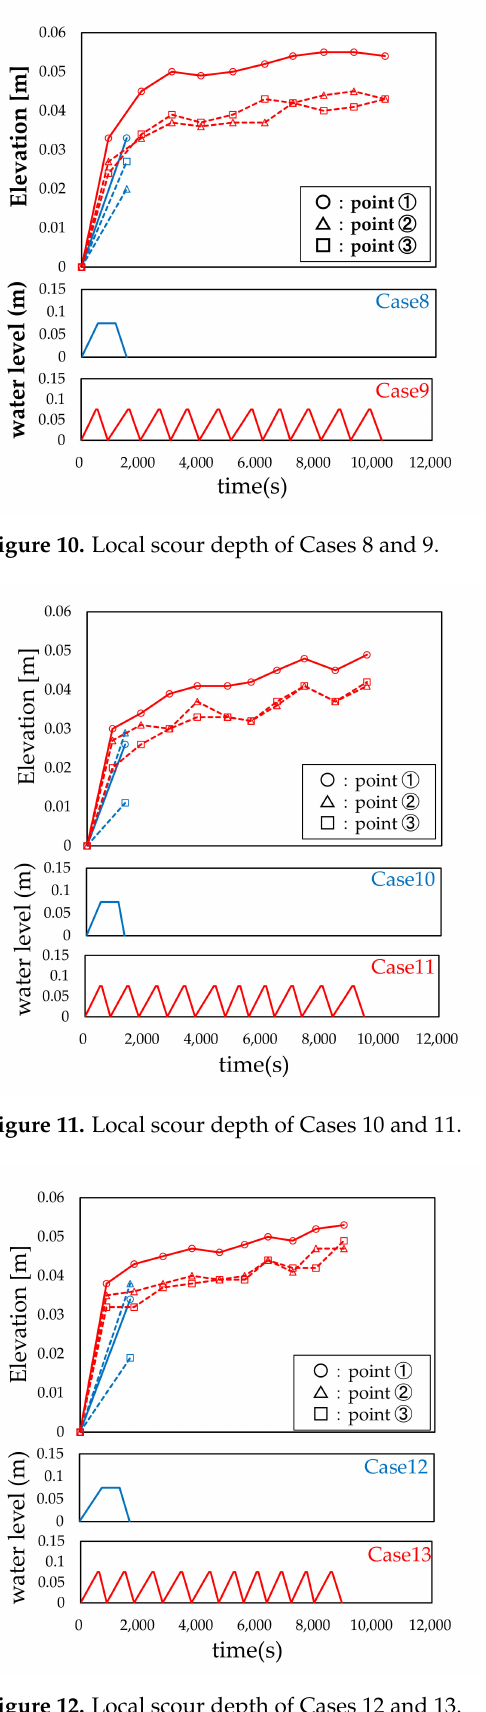
Figure 12. Local scour depth of Cases 12 and